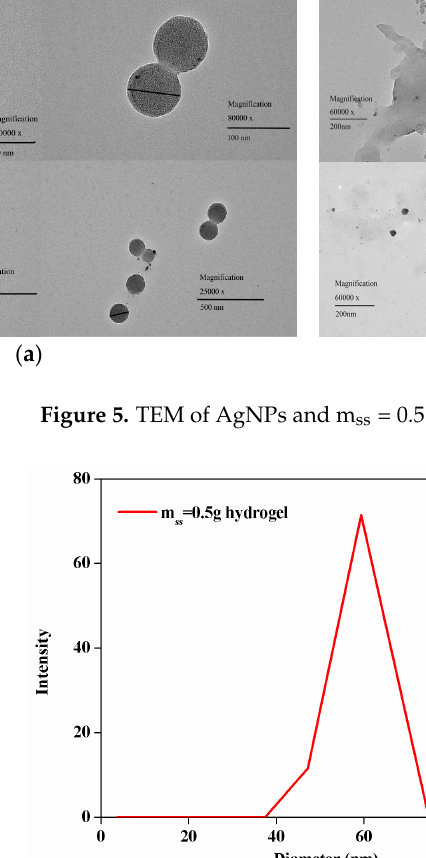
Figure 6. Dynamic Light Scattering of m ss = 0.5 g hydrogel.